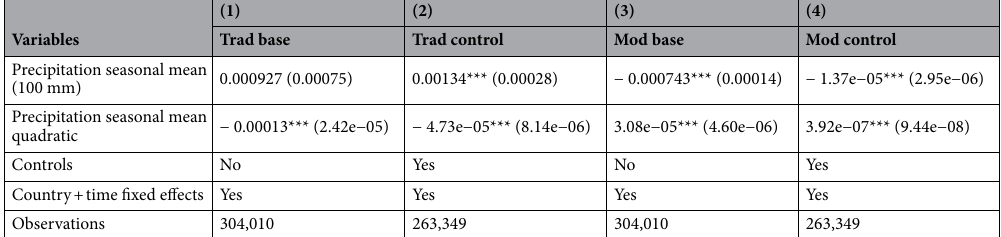
Table 3. Model estimated replacing drought indicator with seasonal rainfall. Clustered standard errors in parentheses ***p < 0.01, **p < 0.05, *p < 0.1.